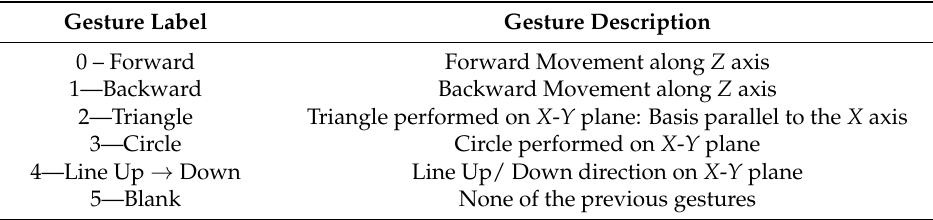
Table 2. Vocabulary of